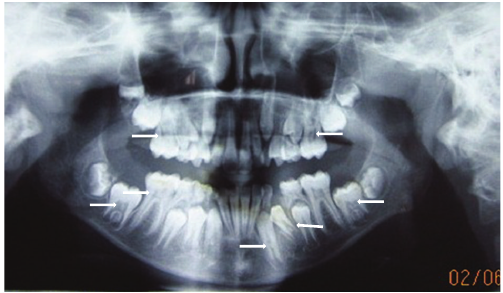
Figure 5: OPG revealing pulp stones in all primary molars and almost in all permanent